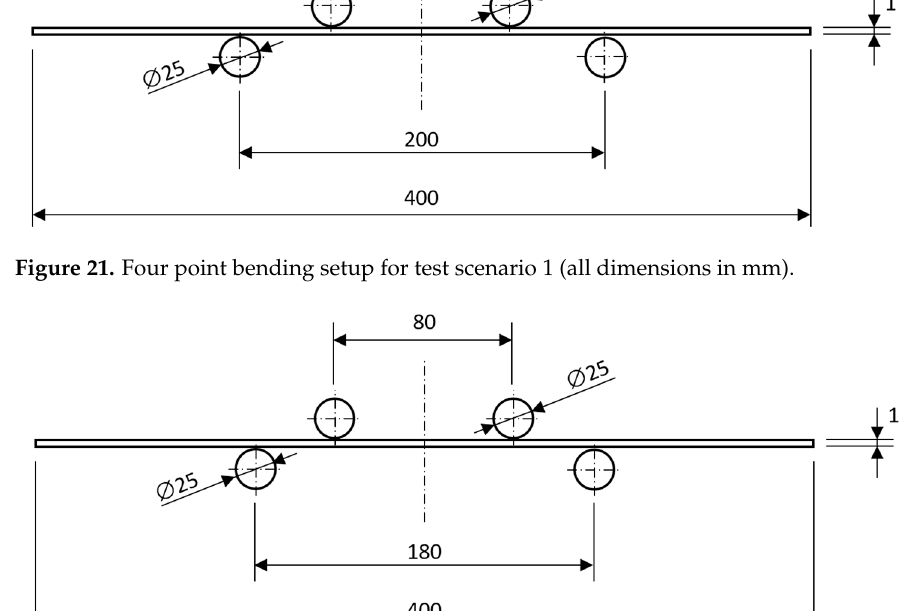
Figure 22. Four point bending setup for test scenario 2 (all dimensions in mm).